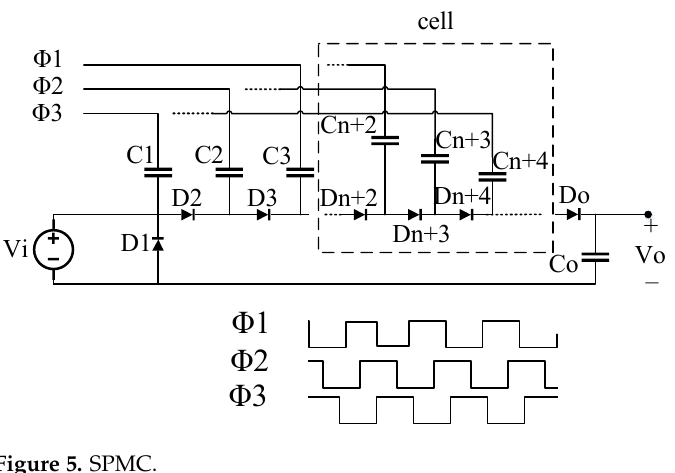
Figure 5. SPMC. Figure 5. SPMC.